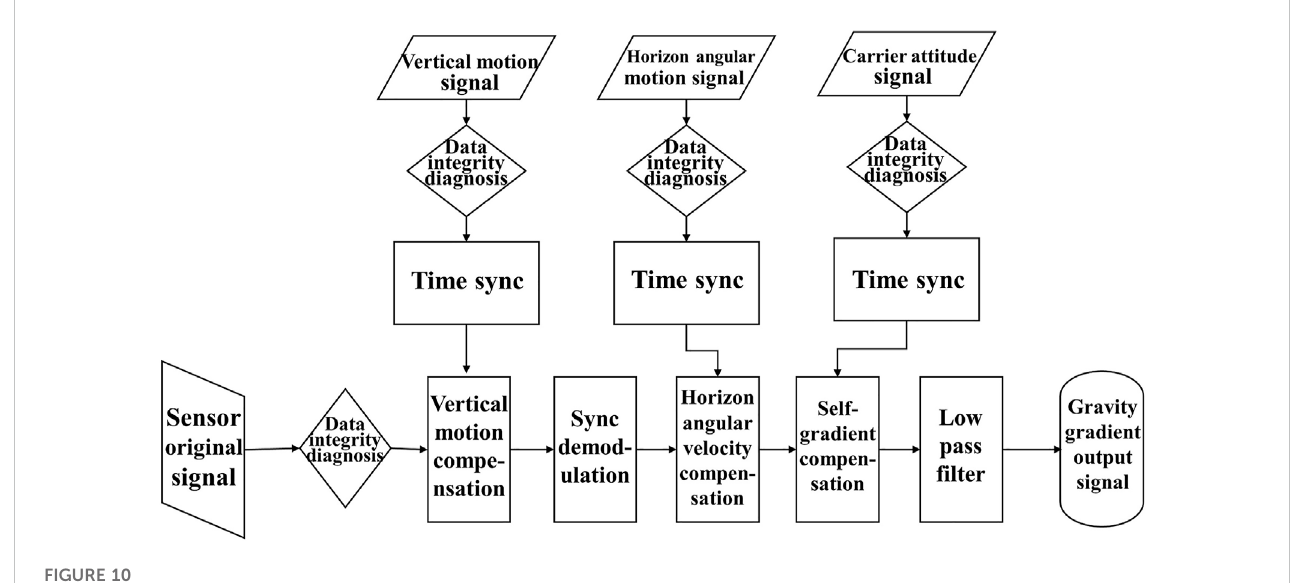
FIGURE 10 Data processing fl owchart of